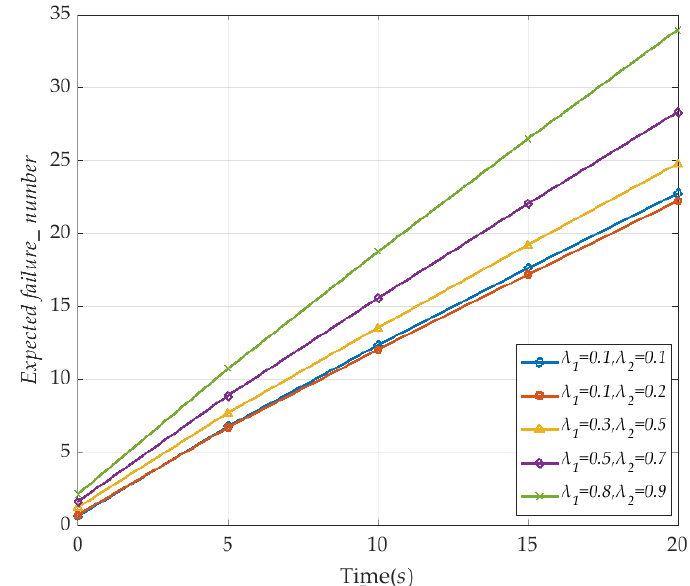
Figure 11. The instantaneous expected failure number of the the V2I network with time (corresponding to μ 1 and μ 2 ).